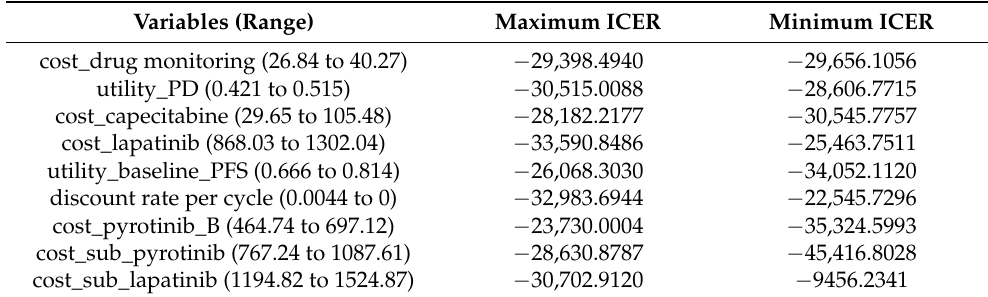
Table A3. The maximum and minimum input values of one-way sensitivity analysis between pyrotinib-B plus capecitabine and lapatinib plus capecitabine.